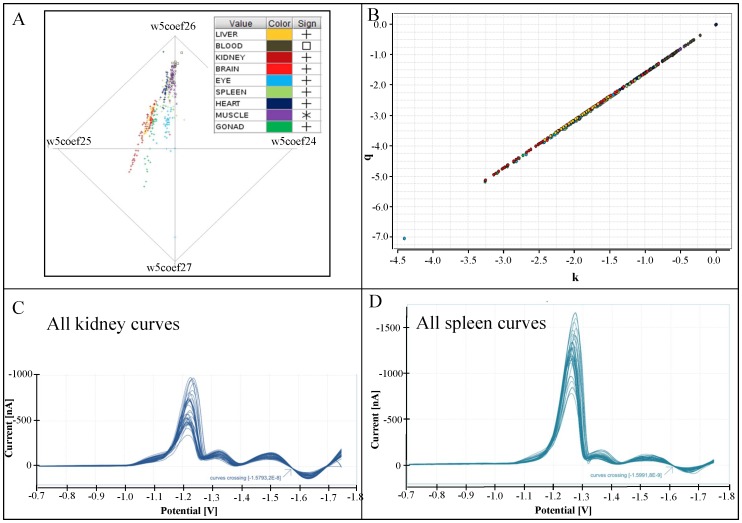
Similarities in DP voltammograms.(A) RadViz image for the w5coef24 … w5coef27 projection of selected wavelet coefficients. (B) Approximation of the Brdicka curve between points Cat2 and Max3 by the line y = kx+q. (C) Cross point for the set of kidney and (D) spleen.